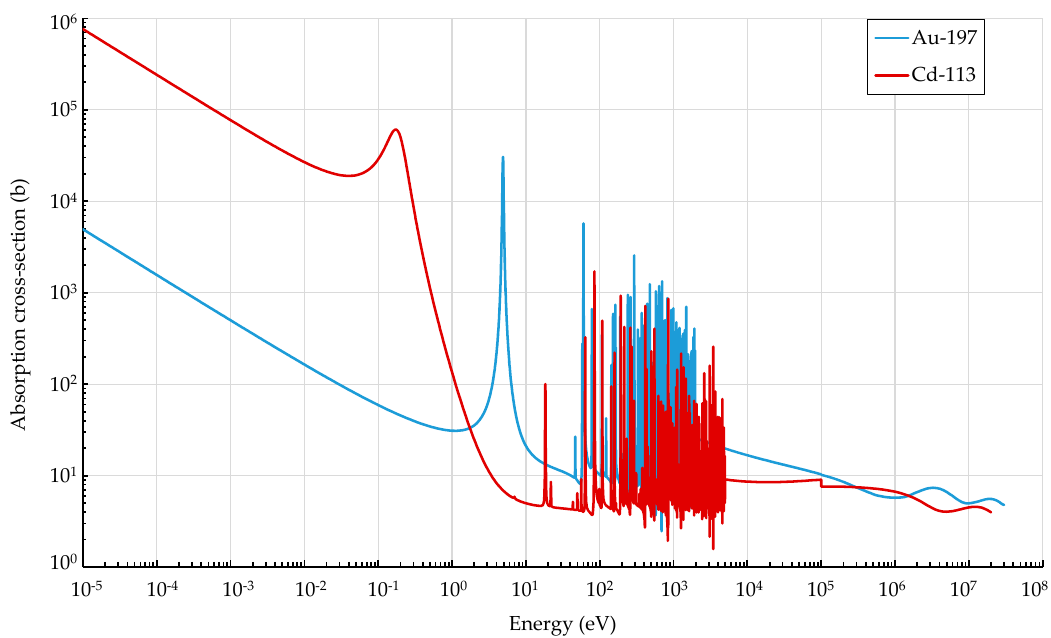
Figure 2. Microscopic absorption cross-section of 113 Cd and 197 Au